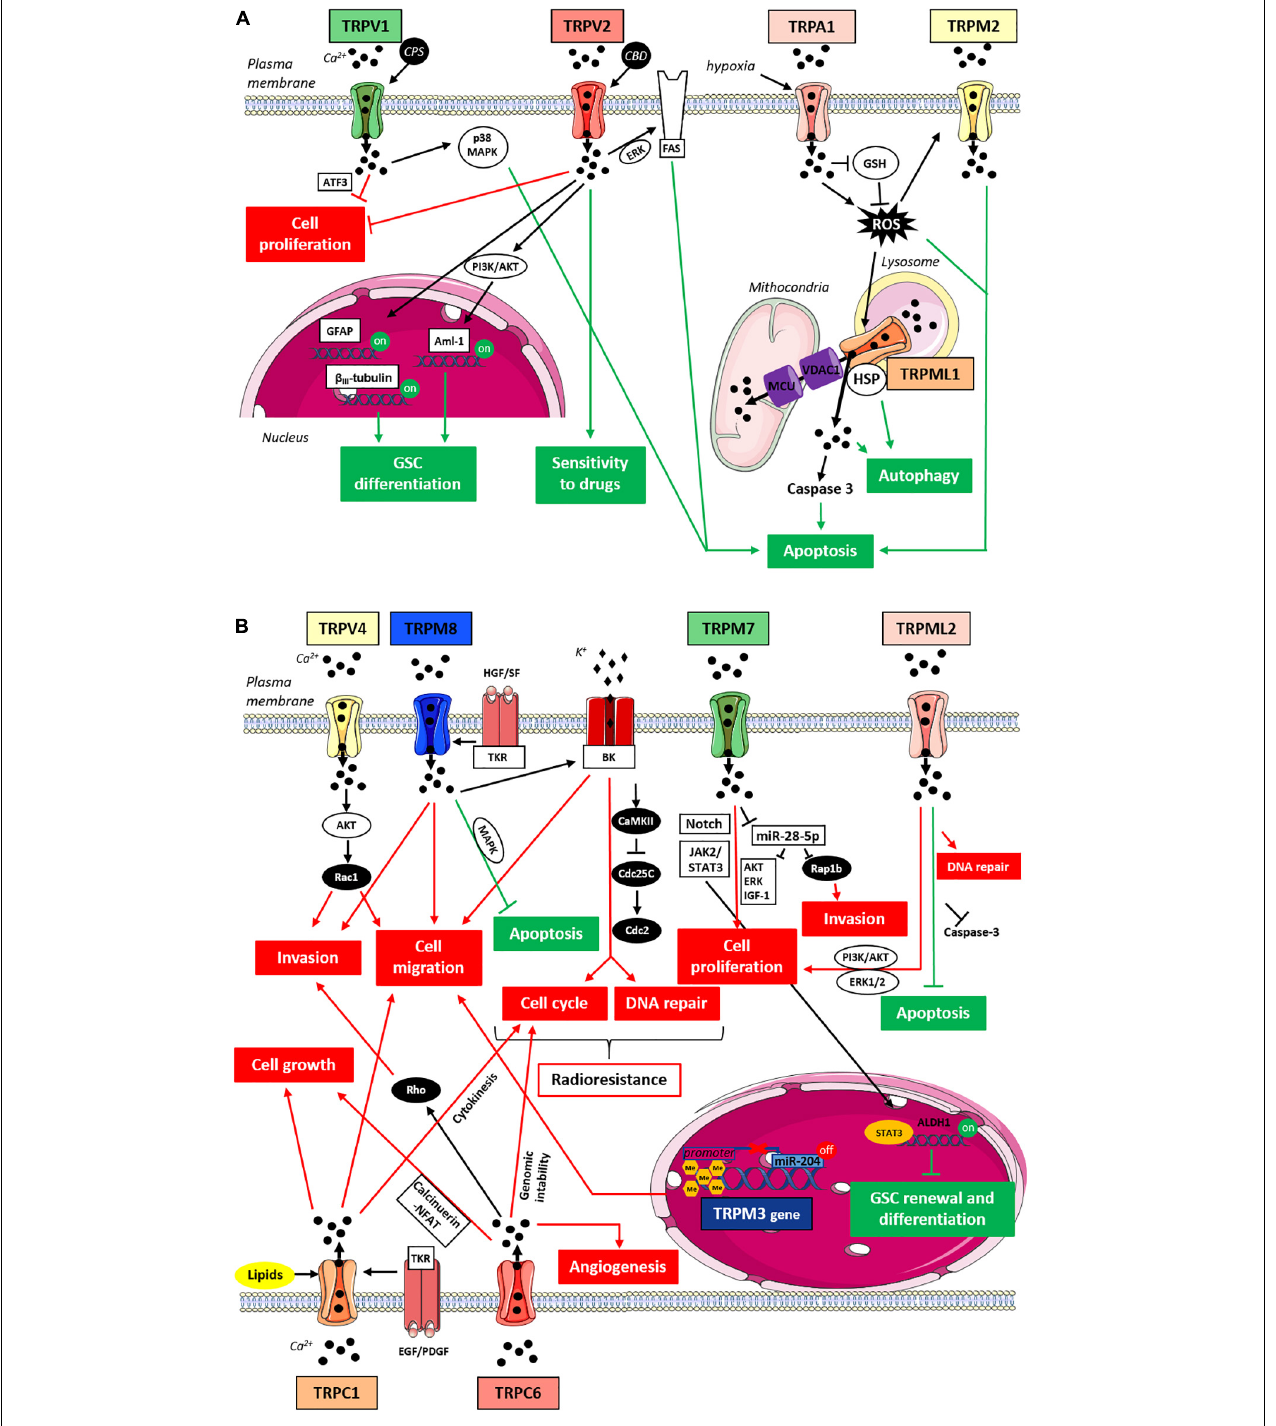
FIGURE 1 | TRPs-mediated signaling pathways in gliomas. (A) Anti-tumorigenic TRPs-mediated signaling pathways in gliomas. Cartoon depicting TRP channels signaling pathways suppressing gliomas progression through the inhibition of pro-tumorigenic pathways (in red) and/or the activation of anti-tumorigenic signaling pathways (in green). TRPM2 and TRPML1 upon ROS activation promote cell apoptosis through an increase in oxidative stress and intracellular Ca 2 + concentration; due to its localization on the lysosomal membrane TRPML1 may also mediates the autophagic cell death pathway through the interaction with HSP; TRPA1 under hypoxia promotes apoptosis inducing ROS formation and inhibiting antioxidants such as GSH; TRPV1 upon stimulation with CPS triggers the apoptotic pathway through p38 MAPK and reduces glioma expansion via ER pathway in a ATF3-dependent manner; TRPV2 reduces cell proliferation and enhances the